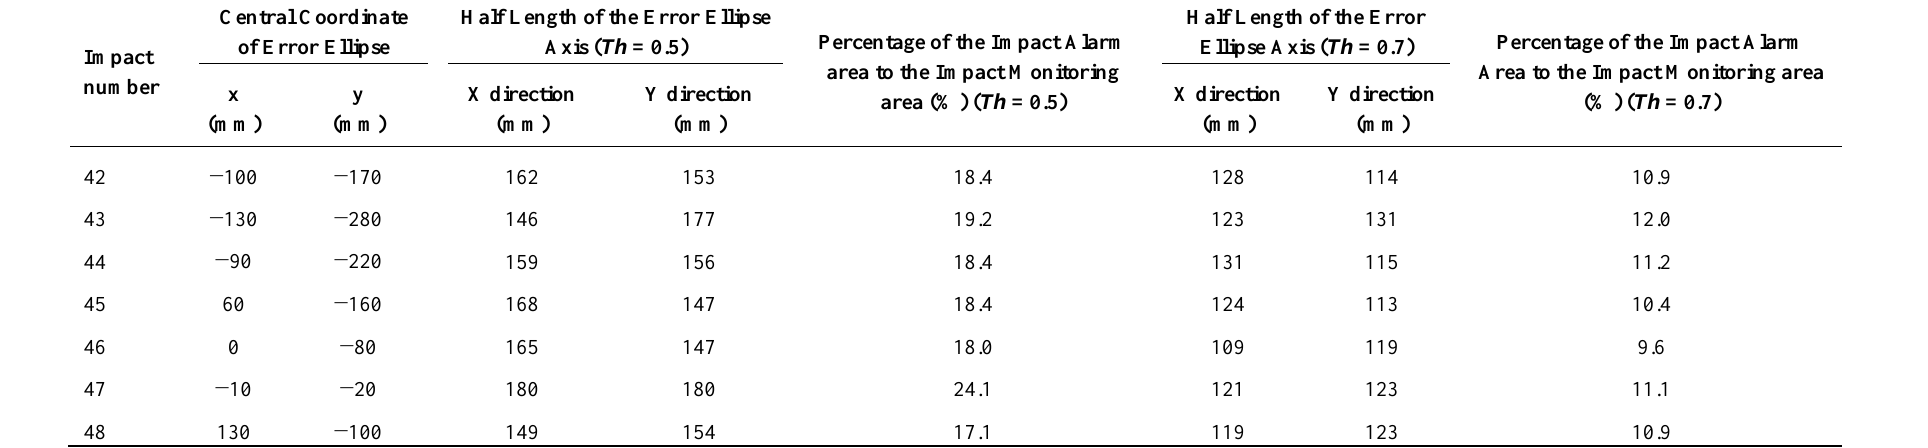
Table 4. Results of impact monitoring region 2 obtained by using impact alarm region imaging